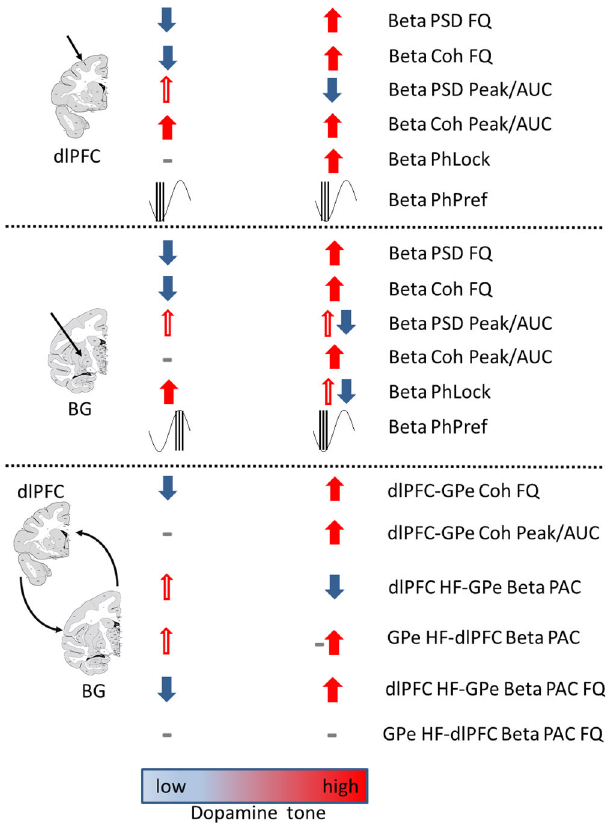
Fig. 9 Results summary. Synopsis of LFP and SUA results. Thick arrows indicate statistically signi fi cant effects. Thin arrows indicate trends that did not reach statistical signi fi cance. A dash indicates no statistical difference. Red arrows indicate increases, blue arrows indicate decreases. Combination of symbols indicates mixed effects. For BG Beta PSD Peak/AUC parameter, thin red arrows represent trends that were signi fi cant for the top 20% of all units. dlPFC: dorsolateral prefrontal cortex, BG: basal ganglia, LFP: local fi eld potential, SUA: single-unit activity, PSD: power spectral density, Beta PSD FQ: frequency of beta oscillation. Beta Coh FQ: frequency of beta coherence; Beta PSD Peak/AUC: power of beta oscillation, measured as nPSD beta peak/AUC; Beta Coh Peak/AUC: beta synchrony, measured as magnitude square coherence beta peak/AUC; Beta PhLock: spike to beta LFP phase locking; Beta PhPref: spikes preferred phase in LFP beta-cycle; PAC: phase amplitude coupling, HF: high frequency. Coronal plane positions marked on atlas schemes (Martin and Bowden 22 ; http://braininfo.rprc.washington.edu/